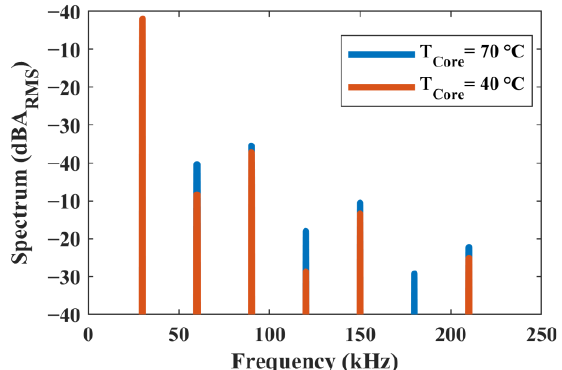
Figure 12. FFT AC spectra of experimental inductor current for a duty cycle of 50% at different temperatures.